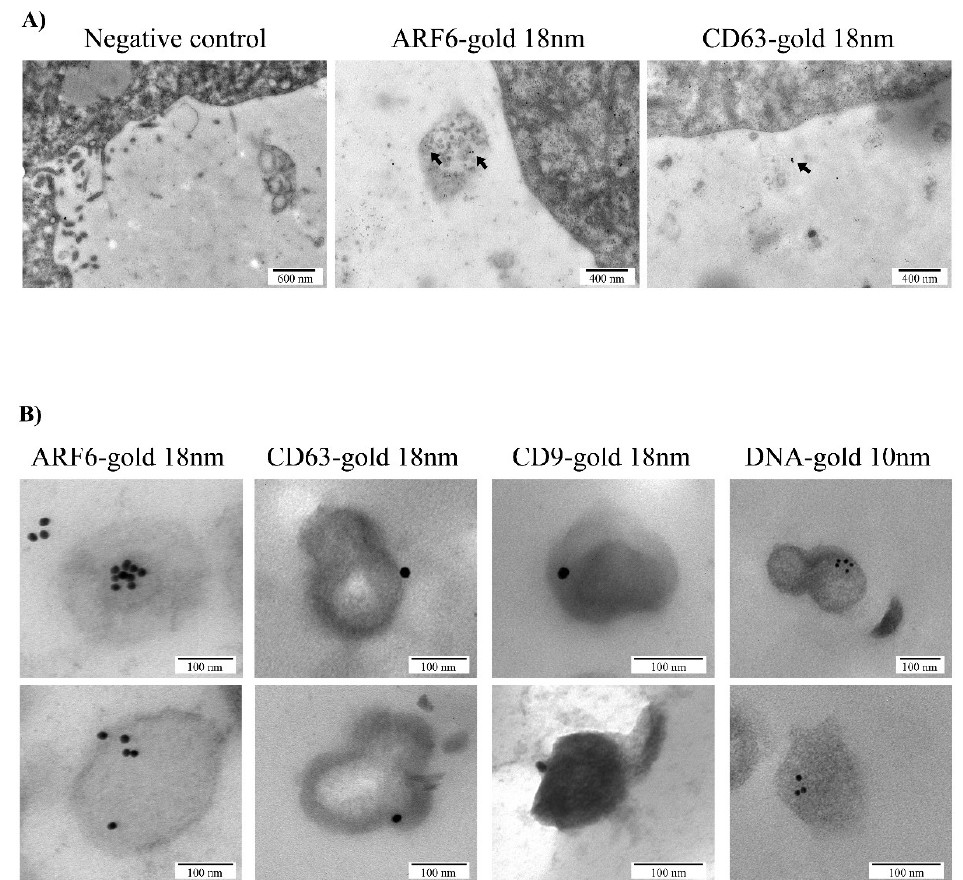
Figure 3. Phenotypic characterization of EVs using immunogold staining. ( A ) Vesicles secreted by the trophoectodermal (TE) cells of murine embryo blastocyst showed positive staining for microvesicles (MVs) and exosomes (EXOs) markers, ARF6 and CD63, respectively. ( B ) Immunogold detection of ARF6, CD63 and DNA in naEVs isolated from spent media of E4.5 blastocysts. ARF6 and CD63 are coupled to 18 nm gold particles; DNA is coupled to 10 nm gold particles. Bars represent 100 µm. Two representative images for each immunogold labeling experiment are included in the